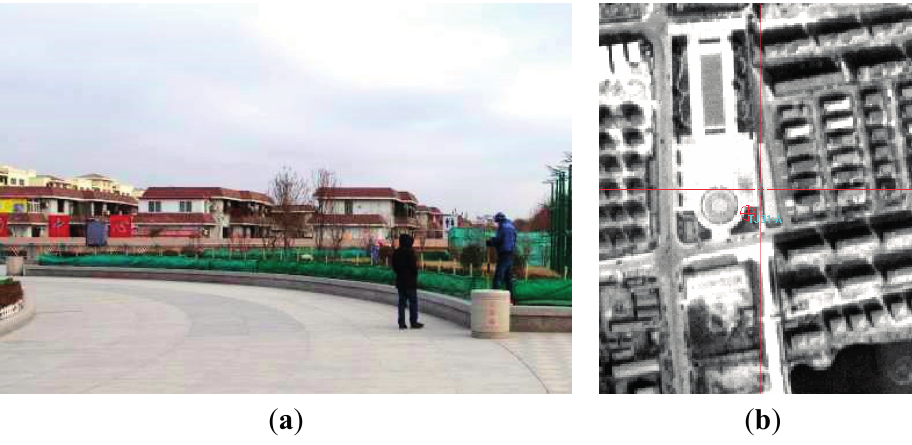
Figure 5. Ground control point (GCP) acquisition. ( a )Field surveying; ( b )Artificial pricking (Nadir